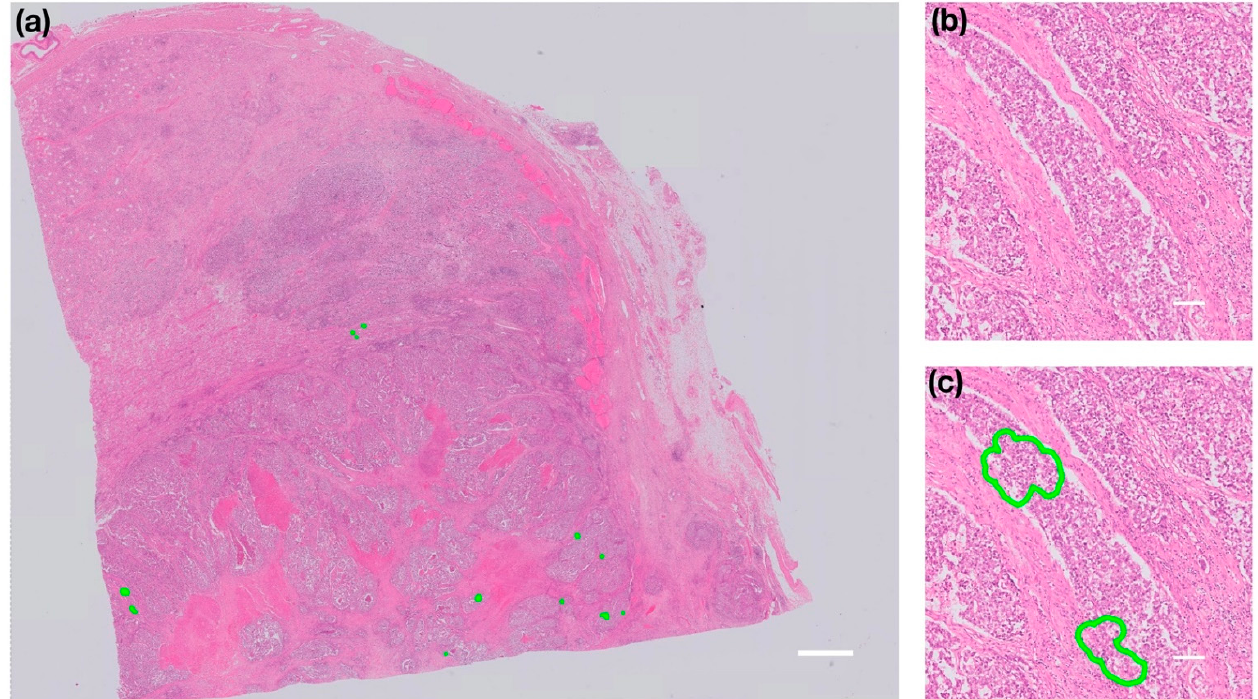
Figure 3. Examples of foci misclassified as LVI within the one failed case. Image ( a ) shows a contrast-enhanced example whole slide image with detected foci highlighted in green. Image ( b ) shows an example high power view of this stroma-rich tumour, and image ( c ) highlights the misclassified foci, in which non-neoplastic stroma mimics blood vessel walls. (Scale bar is 3 mm in the whole slide image and 100 µm in the magnified areas).